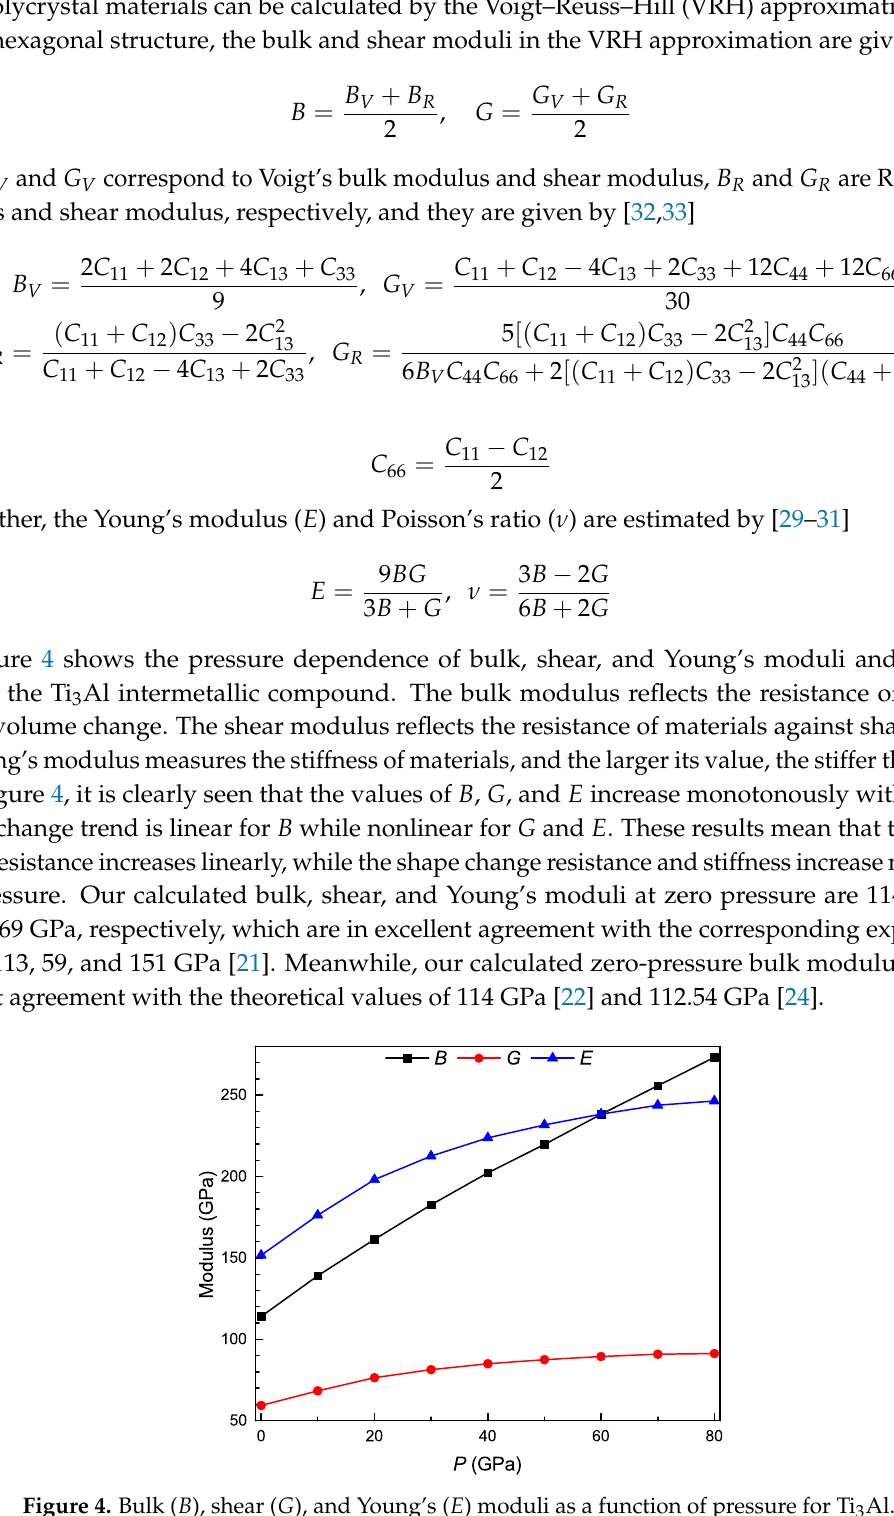
Figure 4. Bulk ( B ), shear ( G ), and Young’s ( E ) moduli as a function of pressure for Ti 3